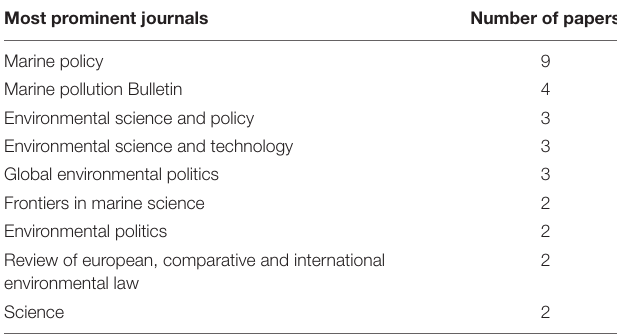
TABLE 1 | The number of publications on global plastic governance in repeating journals.